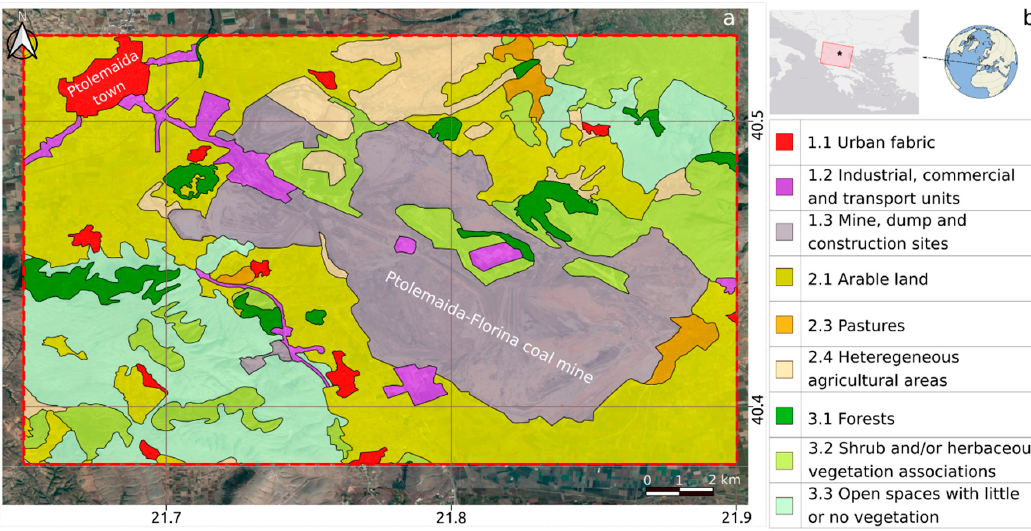
Figure 1. Corine land cover level-2 classes of the study area (Source Copernicus Land Monitoring Service [40]). ( a ) the spatial extent of the AOI is denoted with the red dashed rectangle; ( b ) Sentinel-1 footprint is denoted with filled red rectangle. The reference system is WGS84. © Google Earth background map Copyright 2018. Maps were created using QGIS. QGIS Development Team, 2019. QGIS Geographic Information System (Version 3.8.1). Open Source Geospatial Foundation Project. http://qgis.osgeo.org.